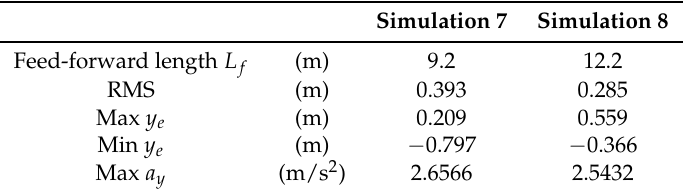
Table 6. Evaluation parameters for variation L f